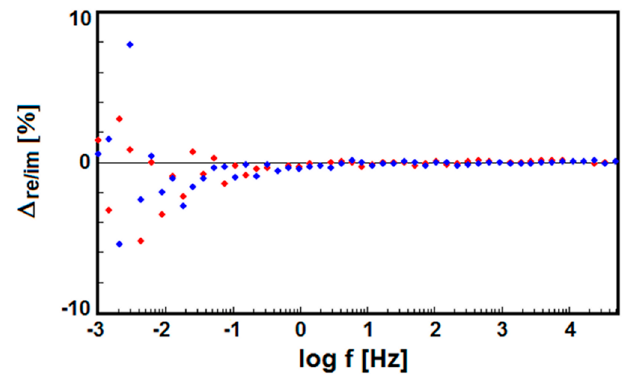
Figure 9. The K–K test residuals for a K–K test of the raw EIS data for the sandblasted Ti G4 electrode obtained at the E cor in ASS at 37 °C. The red dots present the real part differences and the blue dots the imaginary part differences.